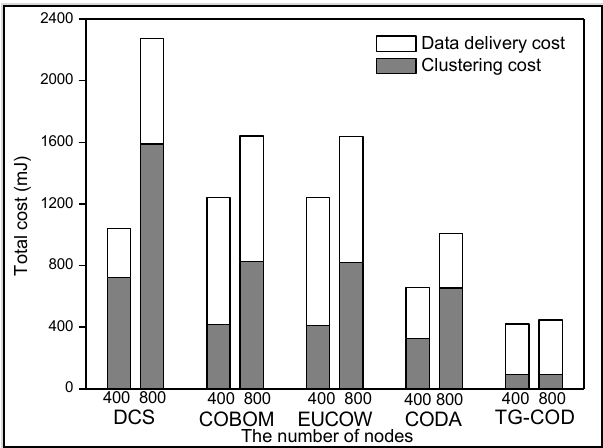
Figure 7. Experimental results for cost with different node densities. Figure 8 shows the number of packet transmissions by the impact of transmission range irregularity. Transmission range irregularity means non-isotropic form of transmis- sion range due to the radio feature. We assumed the irregularity follows Radio Irregularity Model (RIM) with Degree of Irregularity (DOI) = 0.003. This phenomenon makes neigh- bor information asymmetric to each other. In this case, one side transmits packets to its neighbor and expects relaying packet or acknowledgment, but the neighbor might not have reachability. Eventually, it might be regarded as transmission error and causes re-transmission. DCS, COBOM, and EUCOW face this problem more frequently due